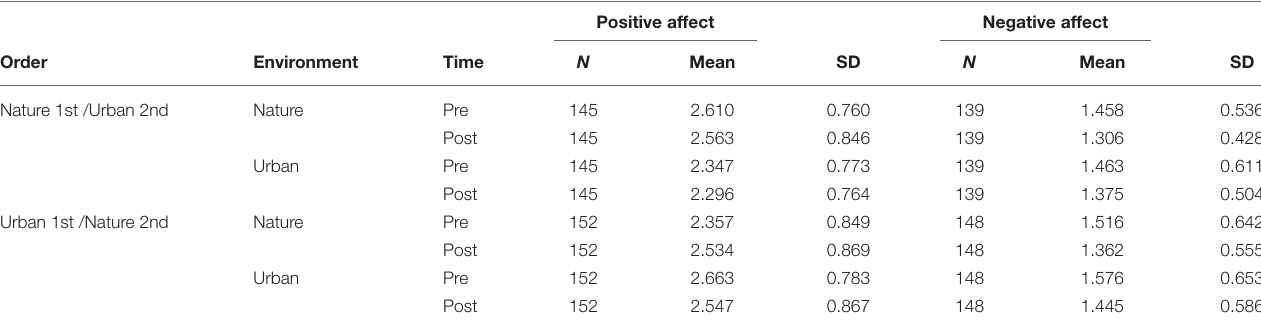
TABLE 5 | Descriptive statistics for Positive and Negative Affect, for study samples with environment as a Within-subjects factor, by the order in which the environment conditions were administered.